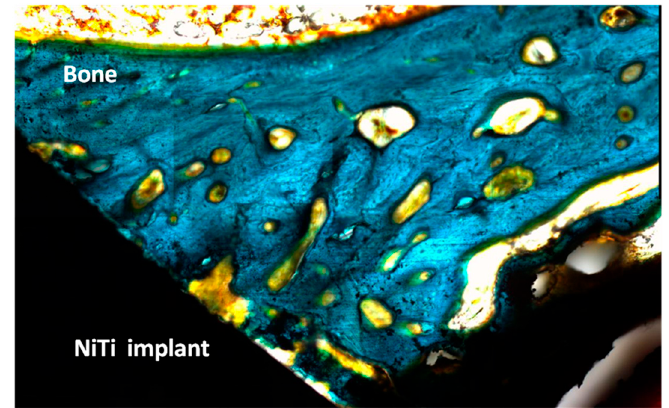
Figure 5. Histological micrograph showing the interface bone–implant for the bioactive NiTi alloy (×400). The implant–bone interface is almost completely covered after six weeks of implantation.